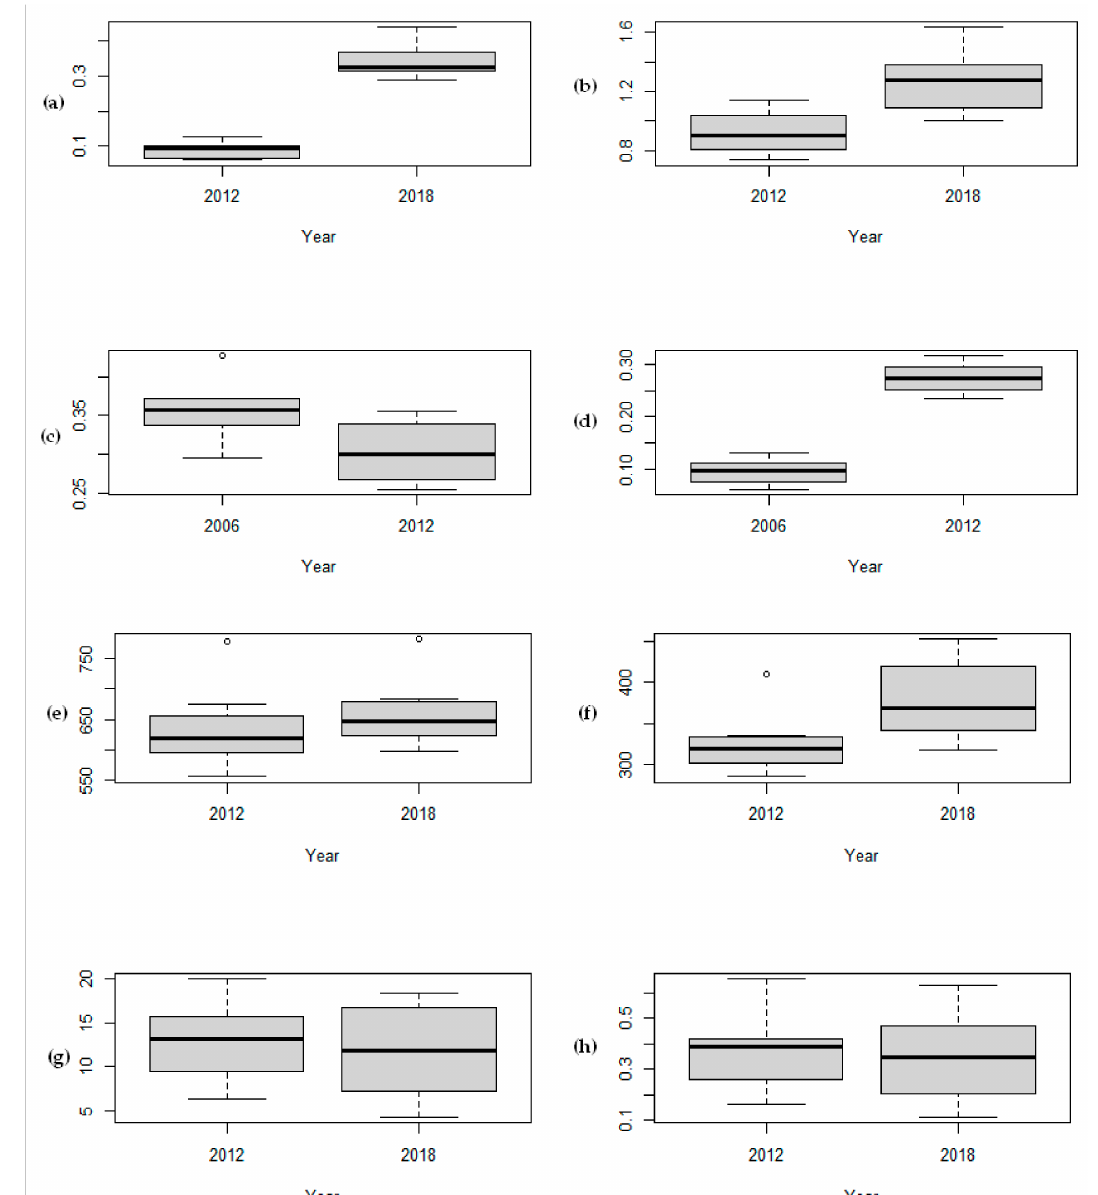
Figure 9. Comparison of the indicators for 2012 and 2018. Note: ( a ) Separated waste in t per 1 household; ( b ) communal waste in t per 1 household; ( c ) waste cost in € ; ( d ) ratio of separated/communal waste; ( e ) average household disposable income in € ; ( f ) net money expenditure of households in € ; ( g ) at risk of poverty percentage; ( h ) people below the poverty line per 1